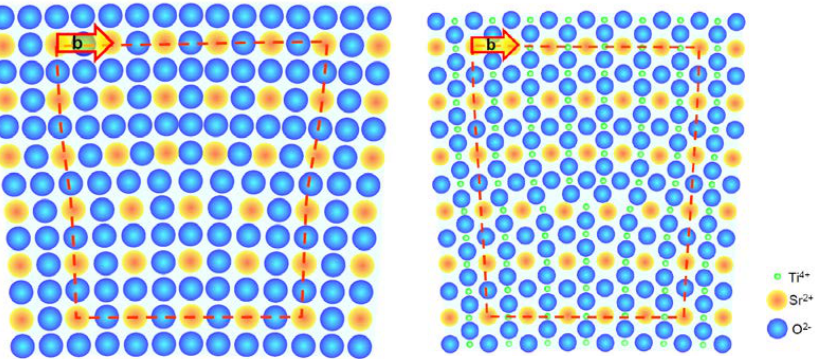
Figure 2. Atomistic models for edge dislocations in the SrTiO 3 perovskite for the <100>{010} ( left ) and <100>{011} ( right ) slip systems. The indicated Burgers vector is b = <100>. Adapted from [72].